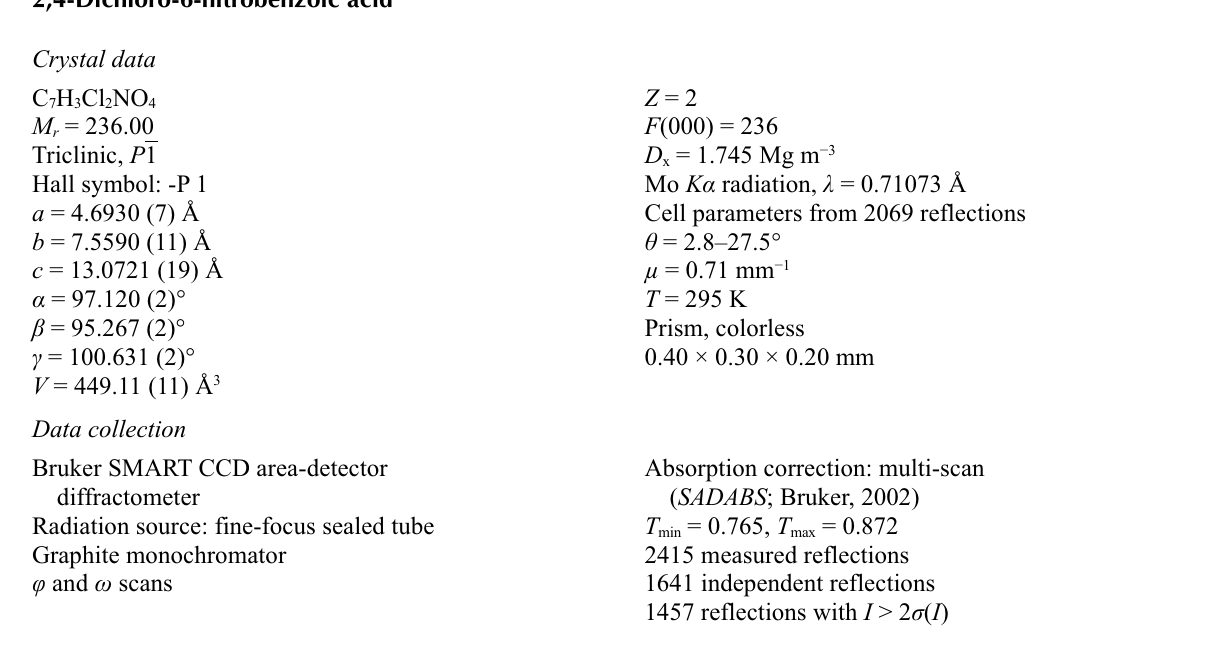
The molecular structure of the title compound with 40% probability displacement